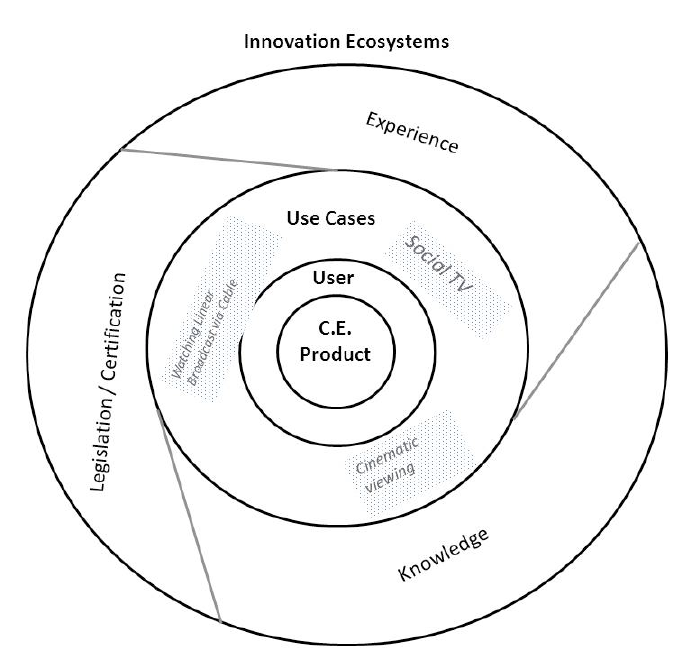
Fig. 2. Innovation ecosystems in the consumer electronics industry. In the centre the product and user can be found. Based on the use-cases the relevant environment is defined. The relevant ecosystem is separated into knowledge, experience and legislation/certification